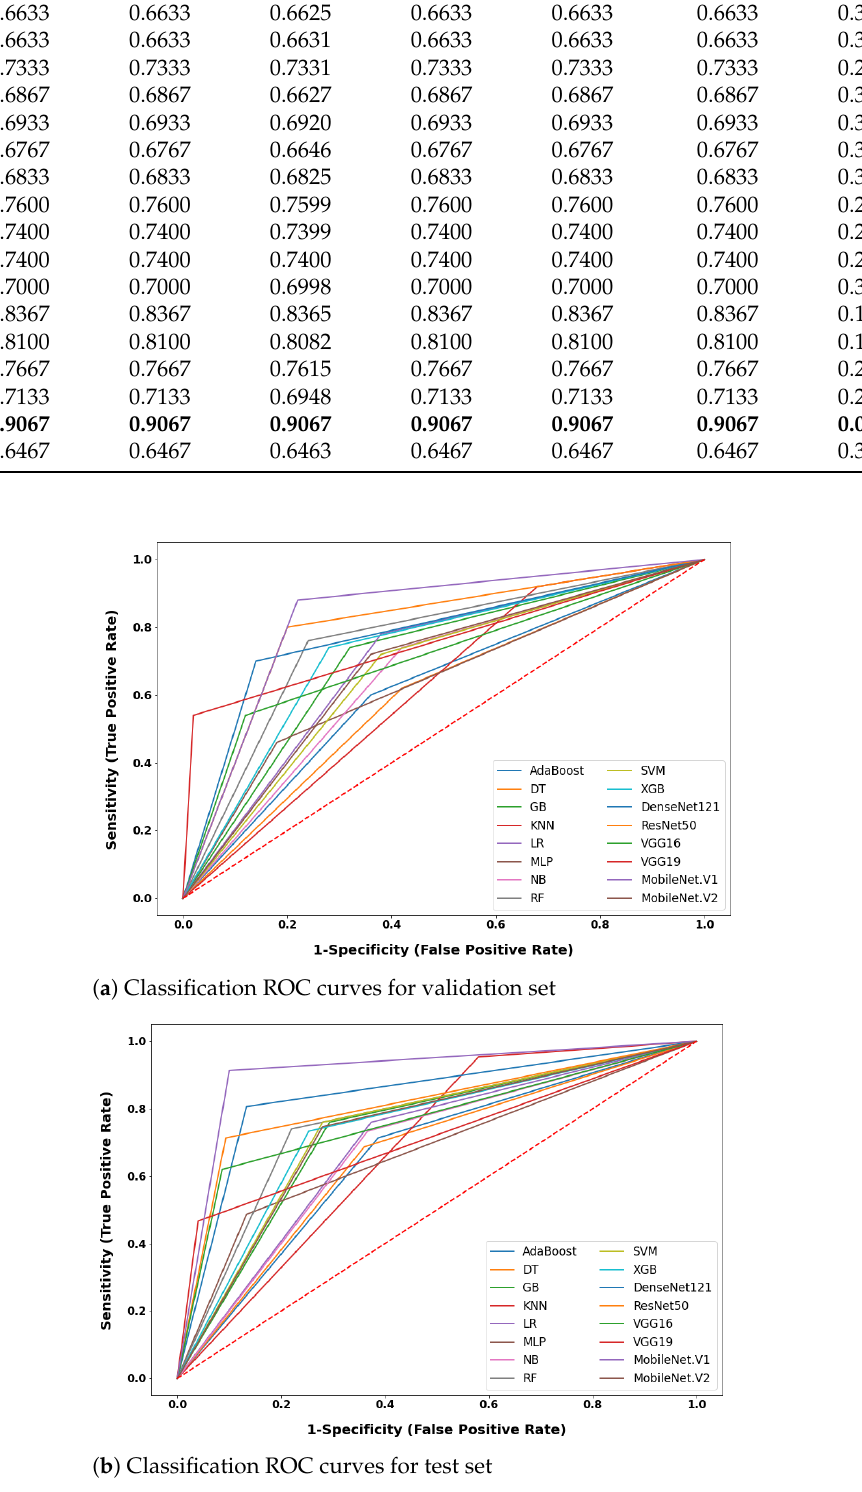
Figure 3. Comparison of ROC curves obtained for ( a ) validation set ( b ) test set using improved MobileNet-V1 along with other